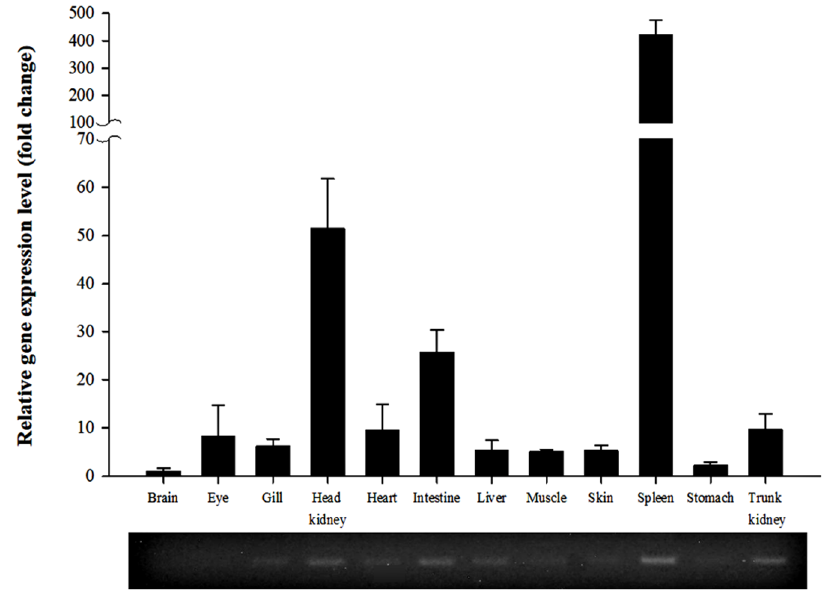
Figure 3. Expression level of PmGal-9 mRNA in various tissues of healthy red sea bream. The PmEF-1α gene was used to normalize the RT-qPCR results. The expression level is expressed as the fold change compared to the expression level of PmGal-9 mRNA in the brain. An agarose gel image of the PCR products is shown at the bottom. All data are presented as the mean ± SD from three independent cDNA samples with three replicates per sample.